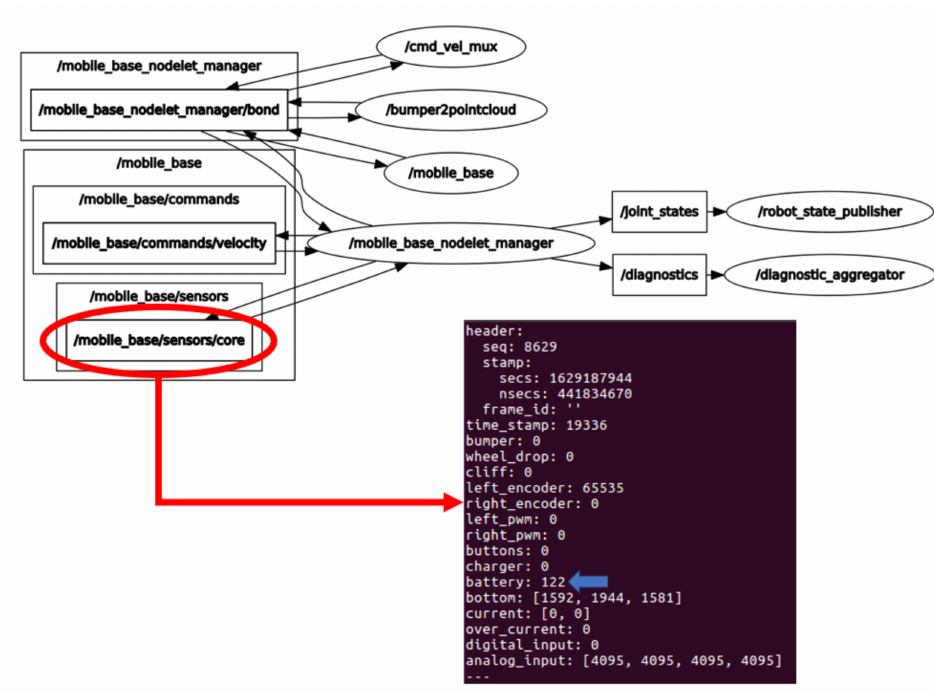
Figure 7. ROS nodes and topics from